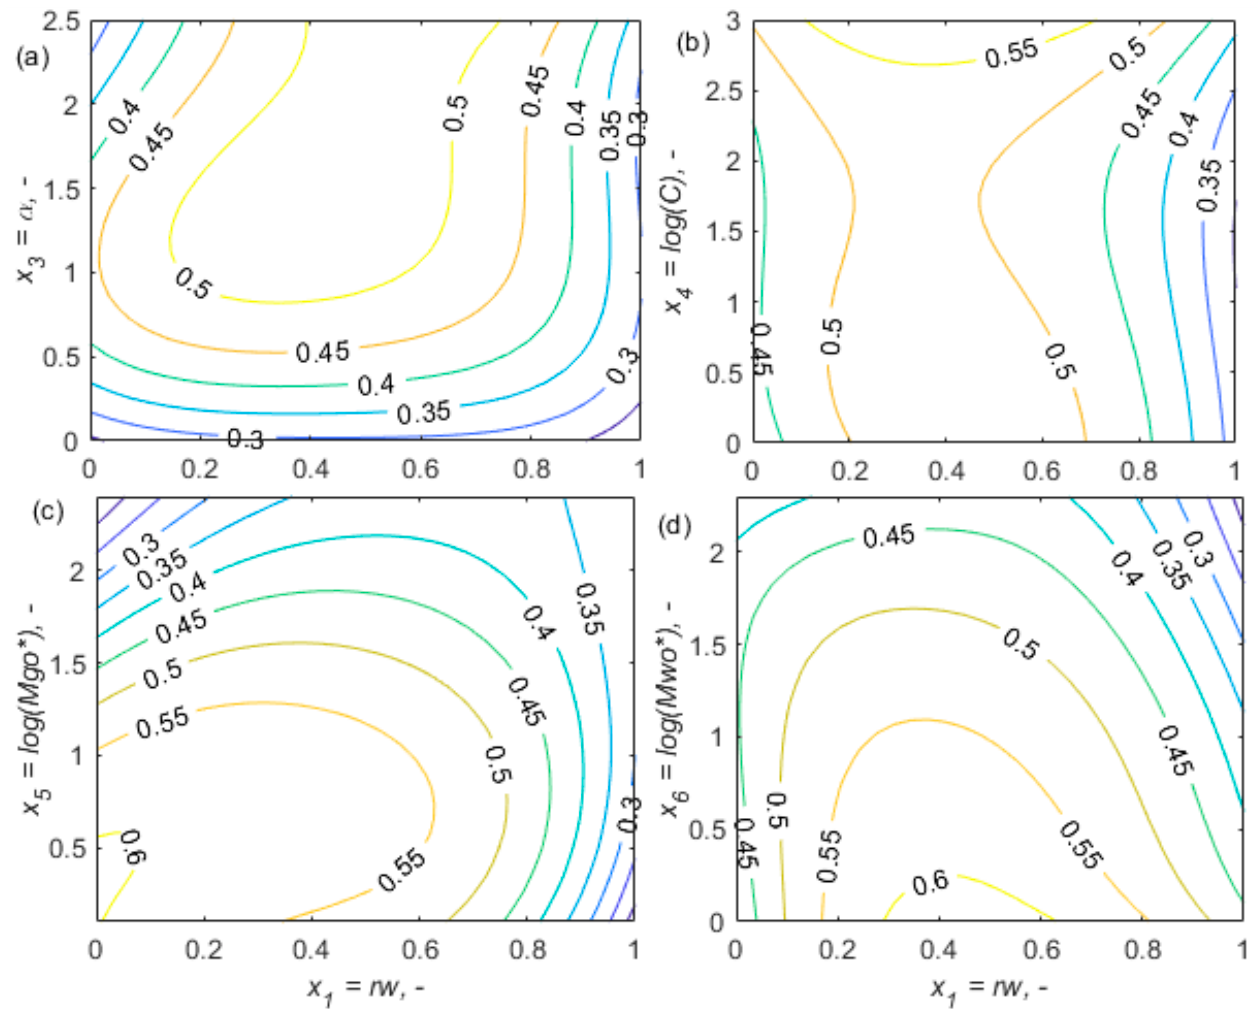
Figure 14. Contour plots of recovery factor RF as function of varying water fraction (horizontal axis) and the indicated parameter ( x 3 in ( a ), x 4 in ( b ), x 5 in ( c ) and x 6 in ( d )) on the vertical axis while holding other parameters fixed. r w = 0 indicates gas injection and r w = 1 water